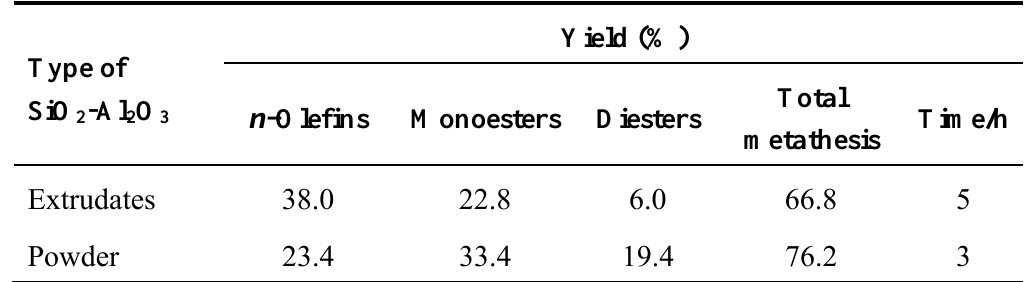
O /SiO -Al O /SnBu catalytic 2 7 2 2 3 4